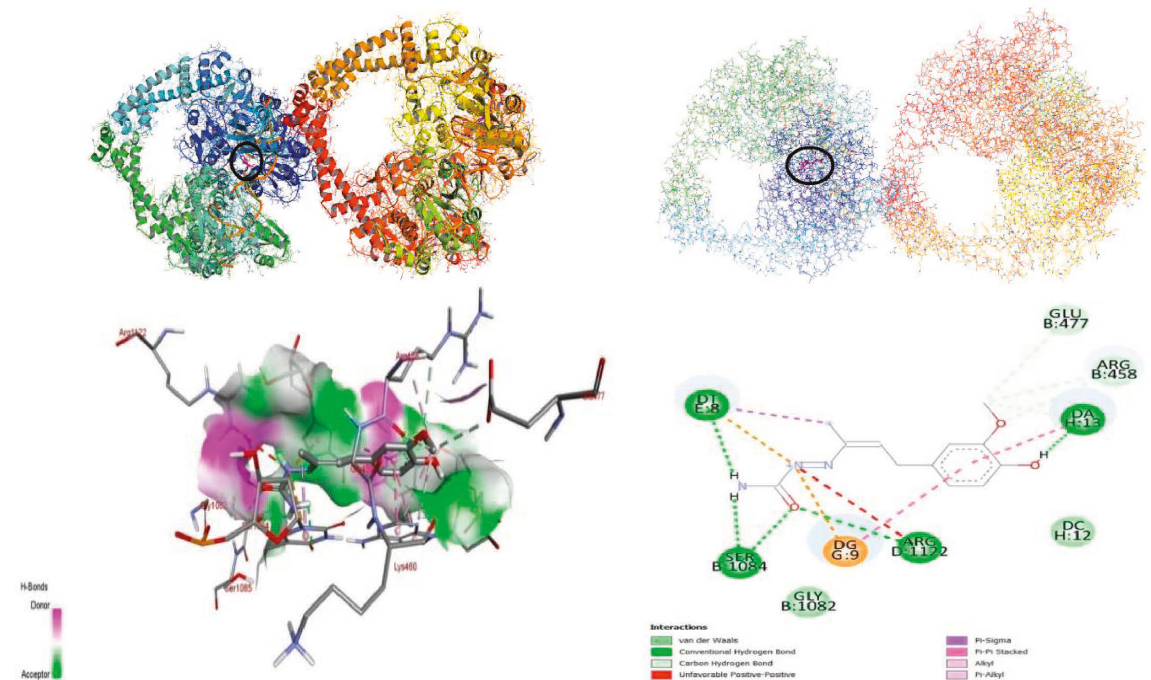
Figure 19: Shows the two- and three-dimensional binding modes of L